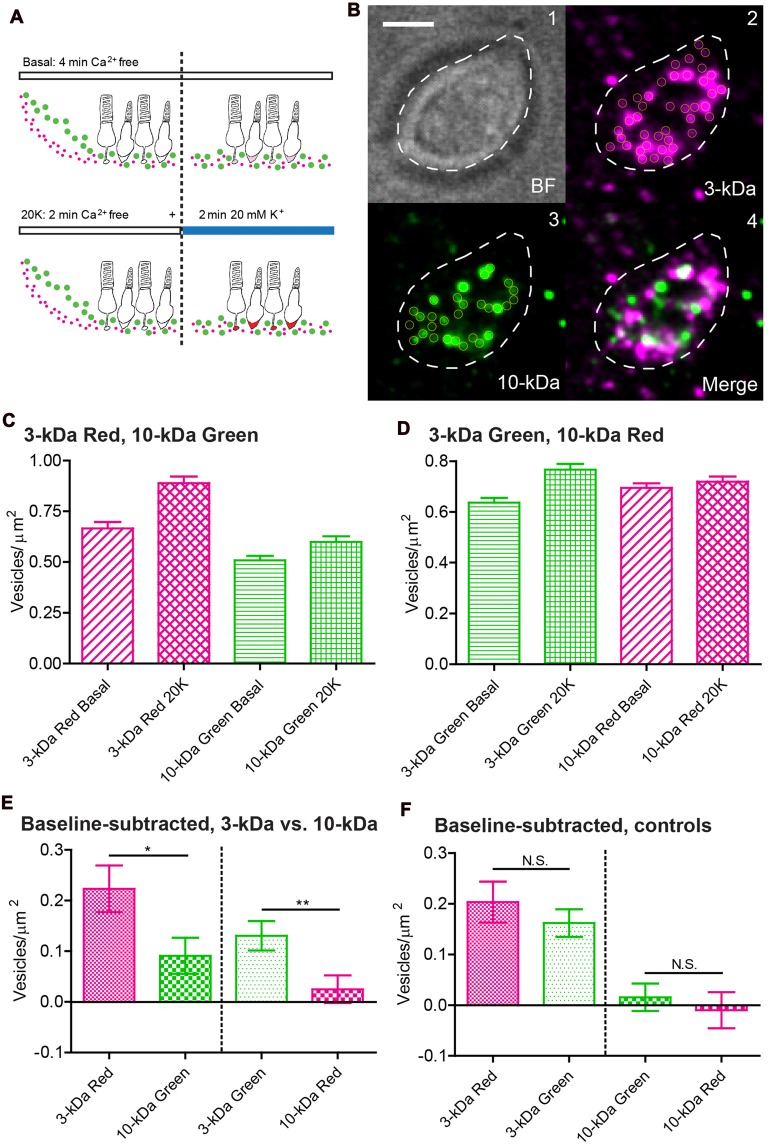
By incubating rods simultaneously in red and green dyes, total internal reflection fluorescence microscopy (TIRFM) imaging of individual synaptic vesicles showed that more vesicles were loaded with small dyes than large dyes. (A) Loading protocol: We incubated retinal pieces for 2 min in Ca2+-free, high-Mg2+ saline to equilibrate dye throughout the retina. To measure basal loading, we maintained retinas for another 2 min in Ca2+-free saline. To measure depolarization-evoked loading, we incubated retinas for the final 2 min in 20 mM K+/1.8 mM Ca2+. (B1) Bright-field image of an isolated rod terminal. (B2) Average TIRFM image (30 × 40 ms/frame, 140-ms intervals) of the same terminal showed many fluorescent vesicles (yellow circles) after incubation with 3-kDa Texas Red. Vesicle brightness in these average images was largely a function of the time each vesicle spent in the evanescent field near the membrane during the trial. (B3) Simultaneous incubation with 10-kDa AlexaFluor-488 loaded fewer vesicles. (B4) Merged image of 3-kDa Texas Red (magenta) and 10-kDa AlexFluor-488 (green) dyes. Scale bar: 2.5 μm. (C,D) Bar graphs show vesicles/μm2 observed using TIRFM under basal Ca2+-free and 20 mM high-K+ conditions. 3-kDa Texas Red vs. 10-kDa AlexaFluor-488 in (C; basal: N = 83 terminals; 20-K+: N = 108); 3-kDa AlexaFluor-488 vs. 10-kDa Texas Red in (D; basal: N = 132; 20-K+: N = 109). (E,F) Bar graphs show vesicles/μm2 observed with high-K+ stimulation after subtracting basal loading. Panel (E) compares loading of 3-kDa vs. 10-kDa dyes. Panel (F) shows control experiments comparing loading of 3-kDa Texas Red vs. 3-kDa AlexFluor-488 (basal: N = 132; 20-K+: N = 116) and 10-kDa Texas Red vs. 10-kDa AlexFluor-488 dyes (basal: N = 113; 20-K+: N = 122). *P < 0.05, **P < 0.01, N.S. P > 0.05 (t-test).